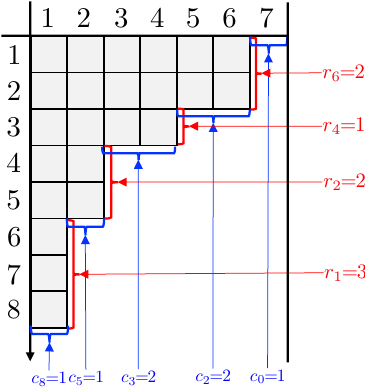
Figure 6. An example of Young diagrams whose maximal length of row is 7